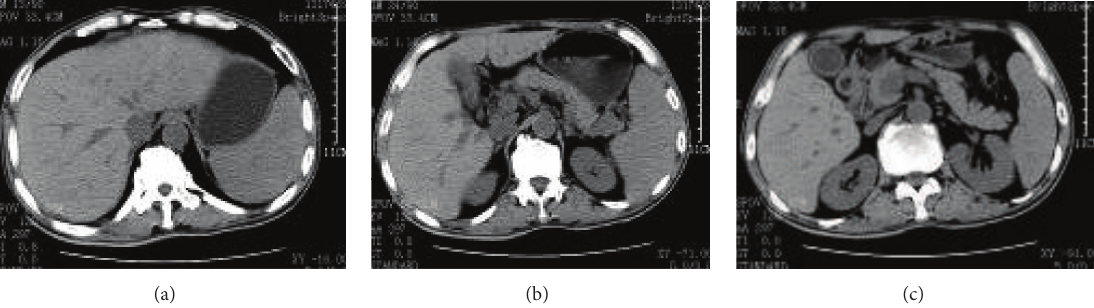
Figure 2: Epigastrium CT after treatment. Note: the liver outline was significantly more prominent. The liver edge was less smooth. Liver parenchymal density was uniform. Multiple quasicircular low-density foci were found in the right lobe of the liver, but no intensified low- density focus was noted. The largest diameter was about 5.5 mm. The spleen was enlarged to approximately seven rib units. The density was uniform. Compared with the CT findings on July 11, the liver density increased and the density was more